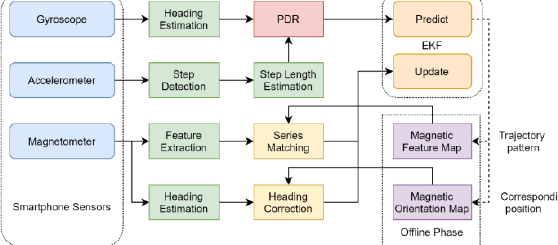
Figure 5. The flow-chart of online positioning and